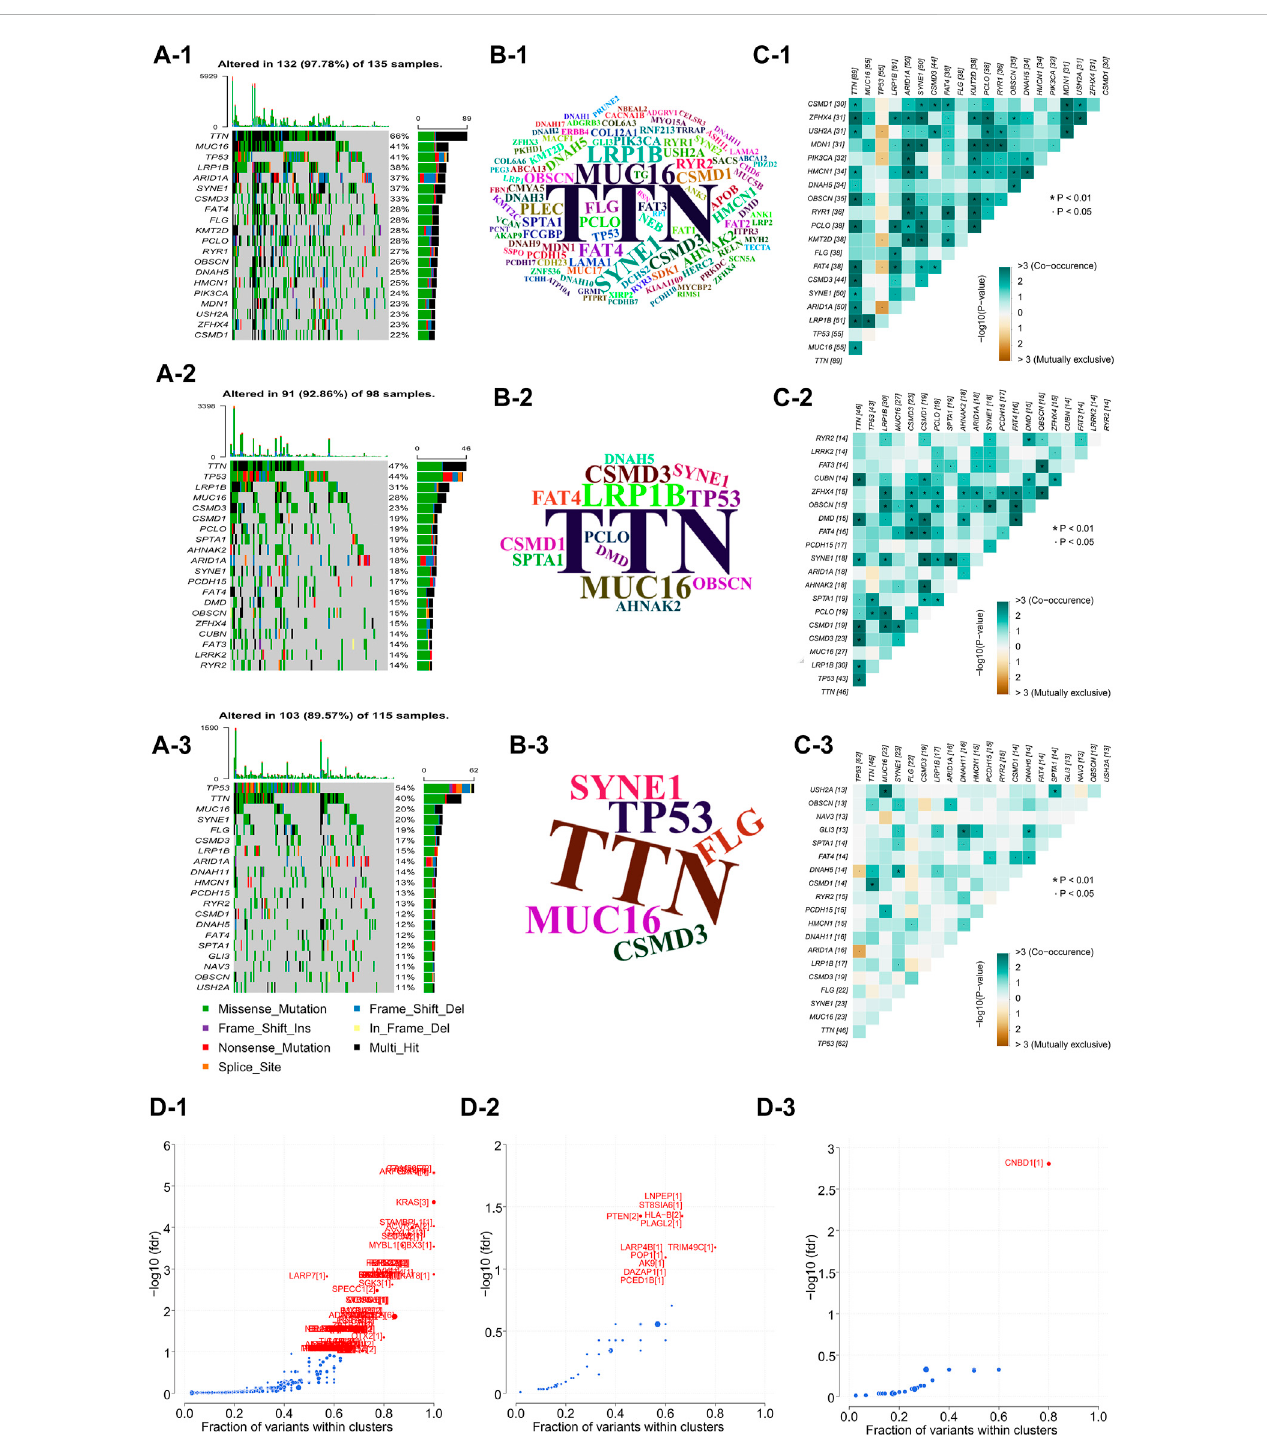
FIGURE 3 Comparison of inter-genomic differences between molecular isoforms (A) Waterfall plot of the top 20 mutant genes in the 3 metabolic subtypes (A-1: NMF_1, A-2:NMF_2,A-3: NMF_3). (B) Wordclouds were drawnwith size ofscriptsbound up withamountsof samples containing certainmutantgenesinthe 3 metabolic subtypes (B-1: NMF_1, B-2: NMF_2, B-3: NMF_3). (C) Correlation heat map to show the degree of correlation between mutant genes in the 3 metabolic subtypes, suggesting that the worse the typing prognosis, the less correlated the mutation is (C-1: NMF_1, C-2: NMF_2, C-3: NMF_3). (D) Volcano map used to demonstrate mutation driver genes in the 3 metabolic subtypes (D-1: NMF_1, D-2: NMF_2, D-3: